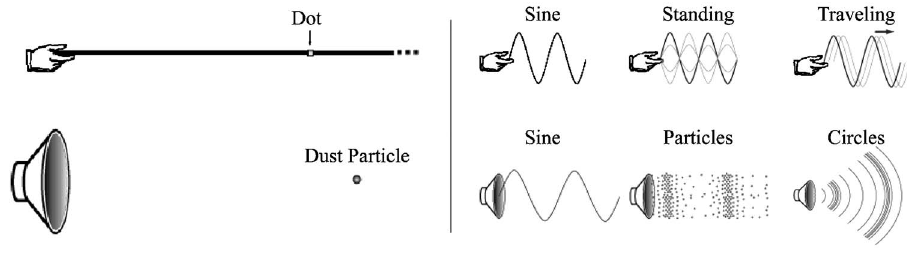
FIG. 5. Left: Pictorial representations from the string (cid:1) top (cid:2) and sound (cid:1) bottom (cid:2) wave representation assessments. Right: Iconographic representations from the wave representation assessments for strings (cid:1) top (cid:2) and sound (cid:1) bottom (cid:2) . The representations are labeled only for reference in this paper—the labels did not appear in the